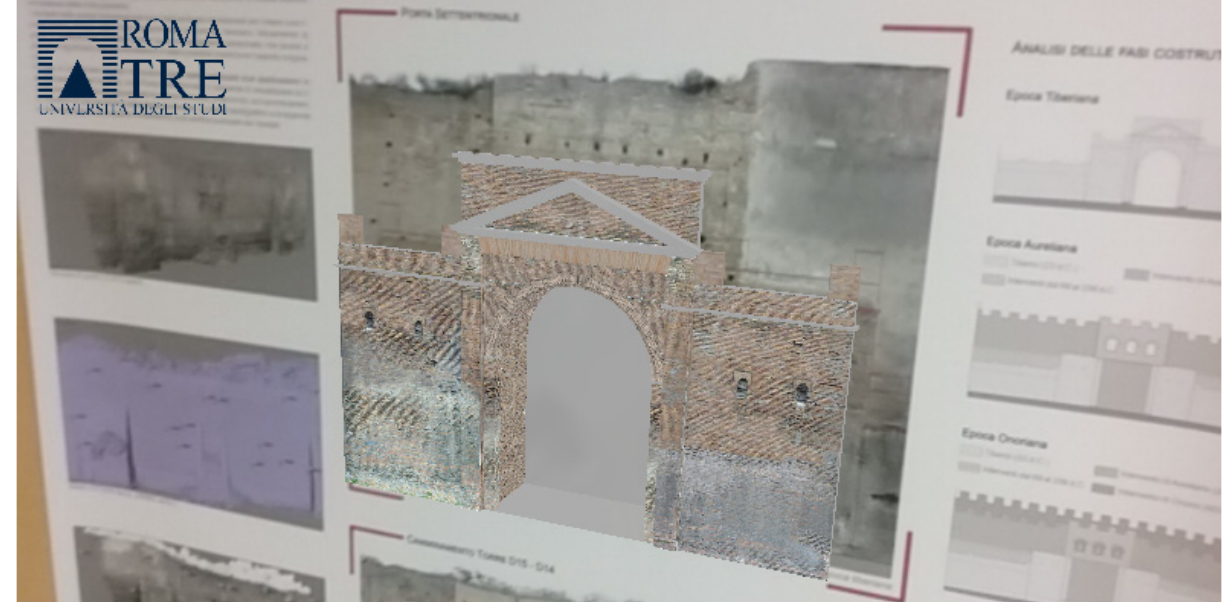
Figure 5. Augmented Reality Off-site, educational